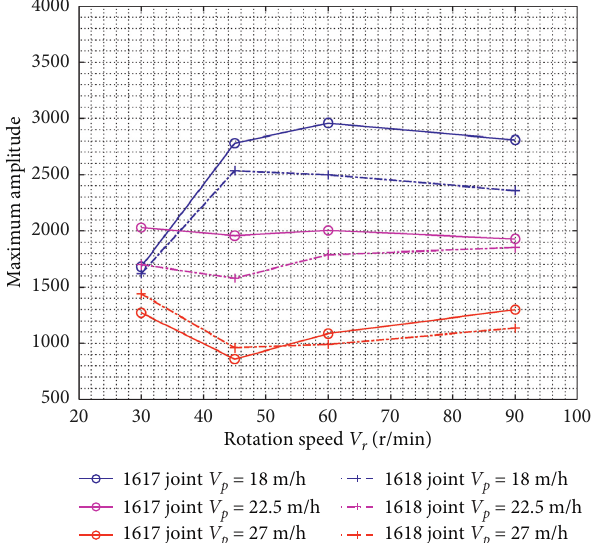
Figure 12: Variation of the maximum amplitude of torque fluc- tuation changing with rotation speed.